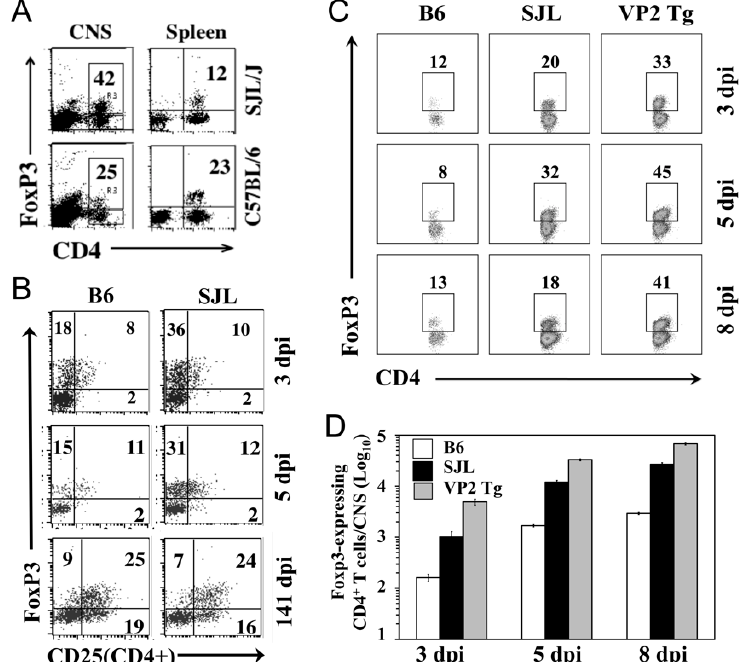
Figure 5. Comparison of FoxP3 + CD4 + T cells in the CNS of C57BL / 6, SJL, and TCR-Tg mice early after TMEV infection. ( A ) The proportions of FoxP3 + CD4 + T cells in the CNS and spleens of TMEV-infected B6 and SJL mice at 5 d postinfection. ( B ) The expression of CD25 on FoxP3 + CD4 + T cells in the CNS of TMEV-infected SJL and B6 mice at 3, 5, and 141 d postinfection. ( C ) The proportions of FoxP3 + CD4 + T cells in the CNS of TMEV-infected B6, SJL, and TCR-Tg SJL mice at 3, 5, and 8 d postinfection. ( D ) The numbers of FoxP3 + CD4 + T cells accumulated in the CNS of TMEV-infected B6, SJL, and TCR-Tg SJL mice at 3, 5, and 8 d postinfection.